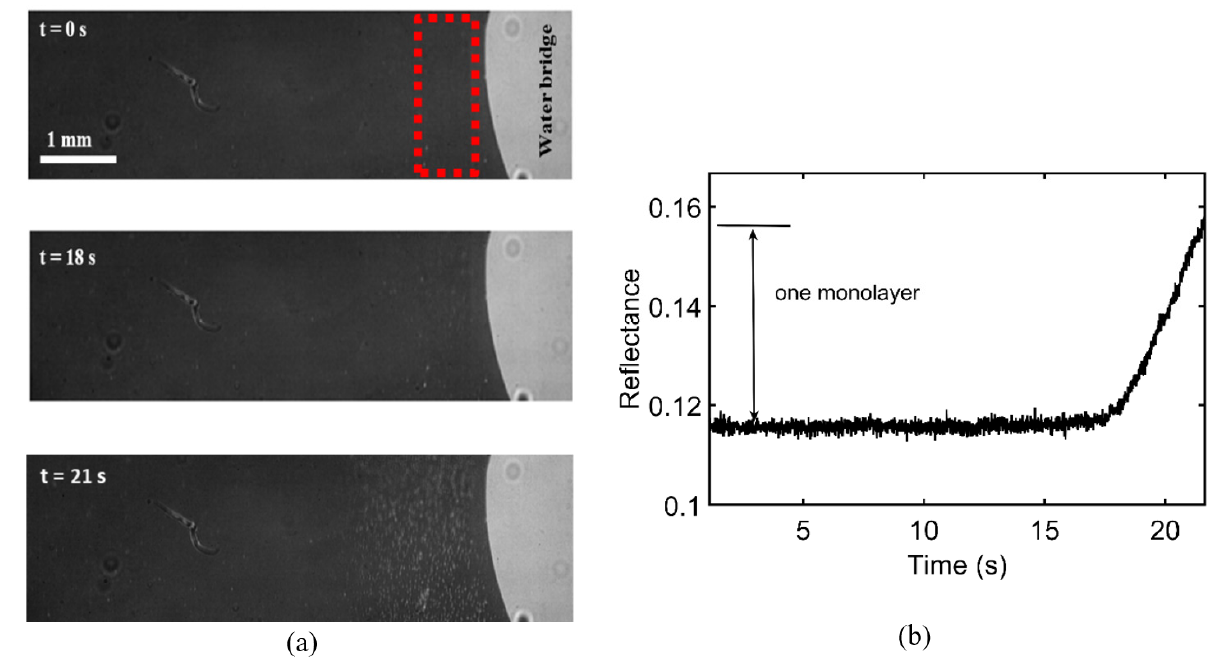
Figure 3. ( a ) Selected time-lapse images recorded (using SPRi at wavelength of 680 nm and temporal resolution of 250 FPS) from the onset of SDC, ( b ) the averaged reflectance of the area in the red box shows no thin film forms on the surface prior to the droplet formation.